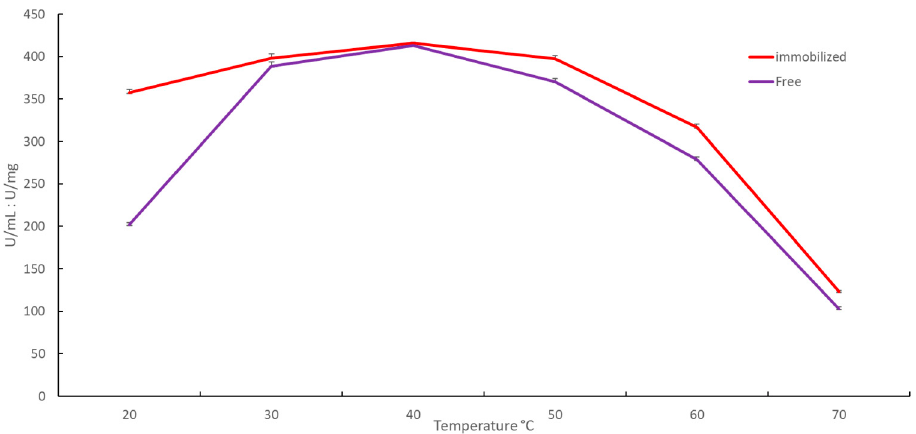
Figure 4. Effect of temperature on immobilized and free YT PTE activity. Red line: Immobilized YT PTE; Purple line: Free enzyme.